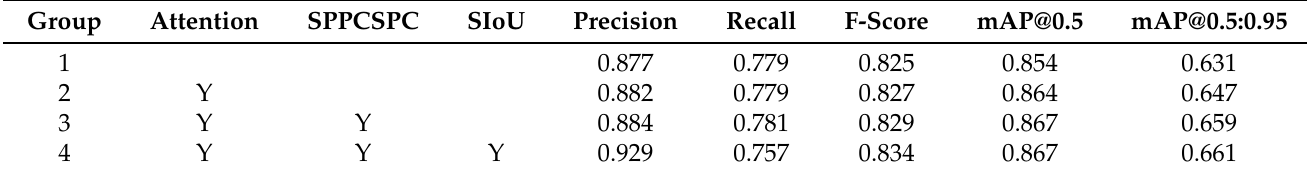
Table 3. Impact of individual components in the development of